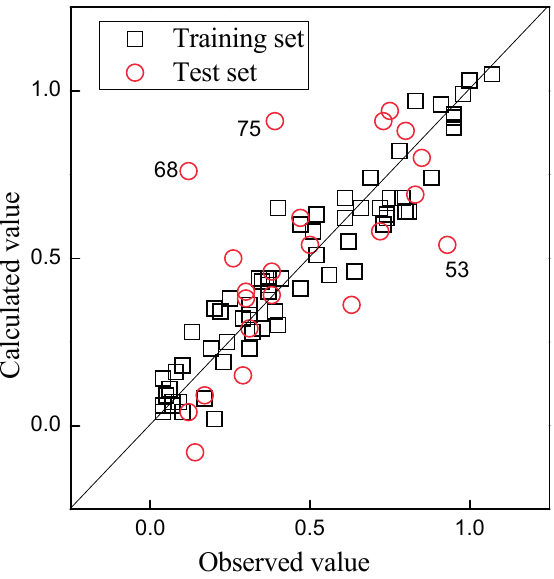
Figure 1. Plot of the CI values calculated by the Partial Least Squares (PLS) models vs. those